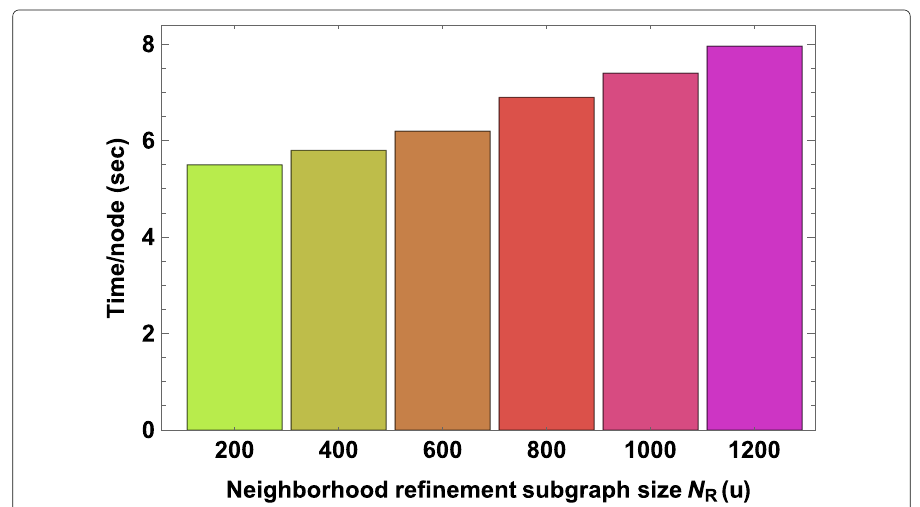
Fig. 9 Runtime analysis for different refinement subgraph sizes when using supergraph as an input graph to SURREAL. The | N R ( u ) | is varied from 200 to 1,200, while | N E ( u ) | and d are set to 1,200 and 128, respectively